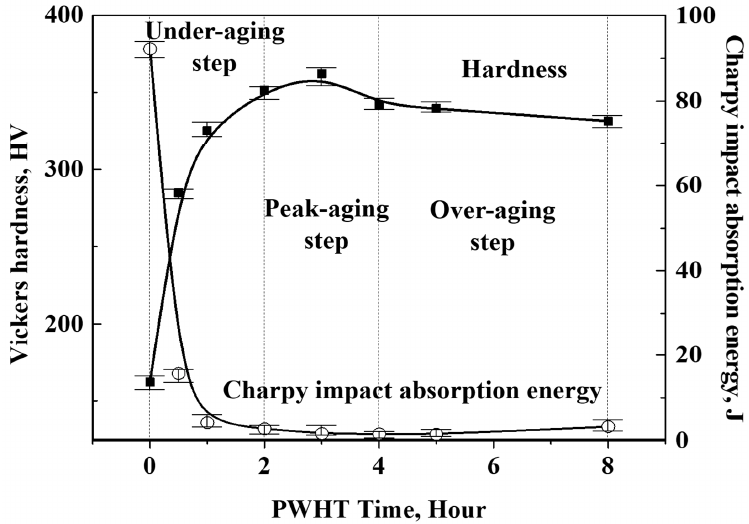
Figure 9. Behavior of the Vickers hardness and Charpy impact absorption energy in the stir zone of FSW joints subjected to a post-weld heat treatment. PWHT: post-weld heat treatment.